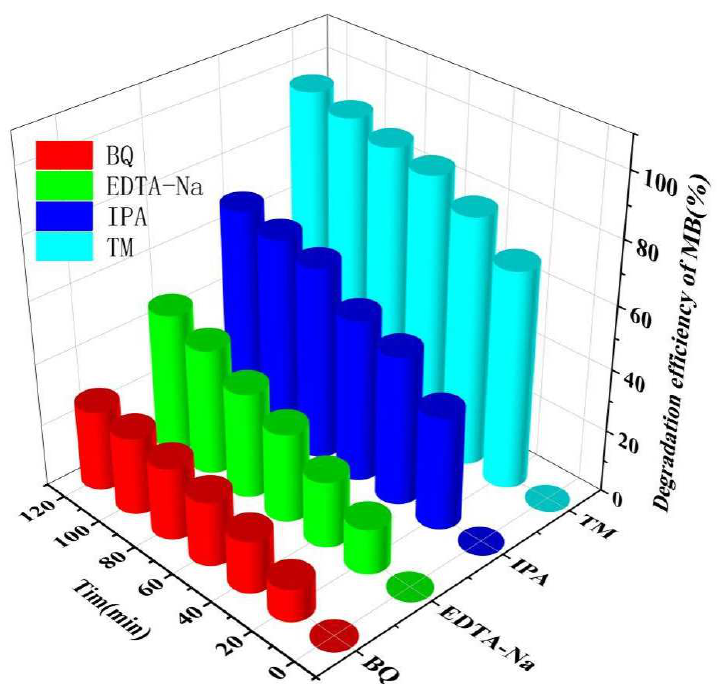
Figure 10. Trapping experiment of active substances during photocatalytic degradation of TiO 2 – MMT.